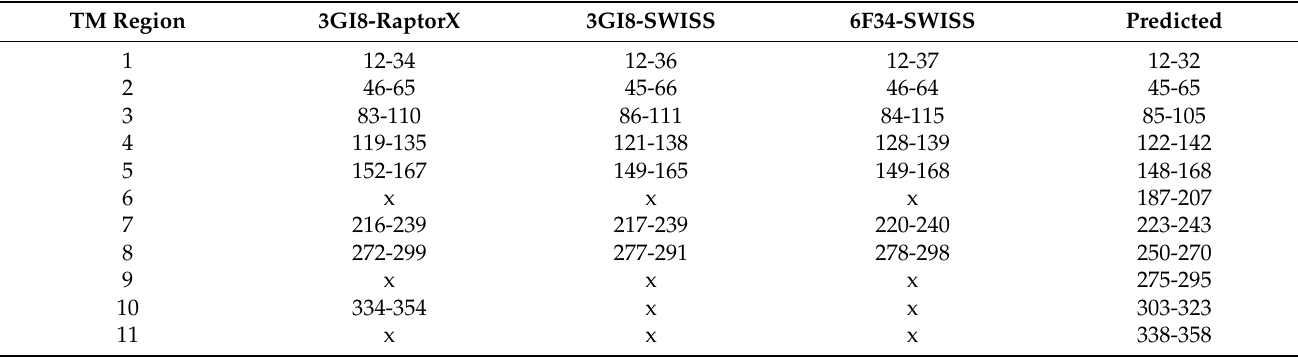
Figure A4. Average residence time and number of binding events for potassium (K + ) to GerAB residues. ( A ) shows the number of binding events for the three models. ( B ) depicts the average residence time of (K + ) against the residue index for the three models. Table A1. Helix topology of GerAB models and TMHMM/Phobius transmembrane helix prediction. For all models, residues that belong to TM6 could not be deduced from the helicity data. Only 3GI8-RaptorX contains TM9 and 10. The structure of TM9 is too flexible to allow for a precise determination of helical